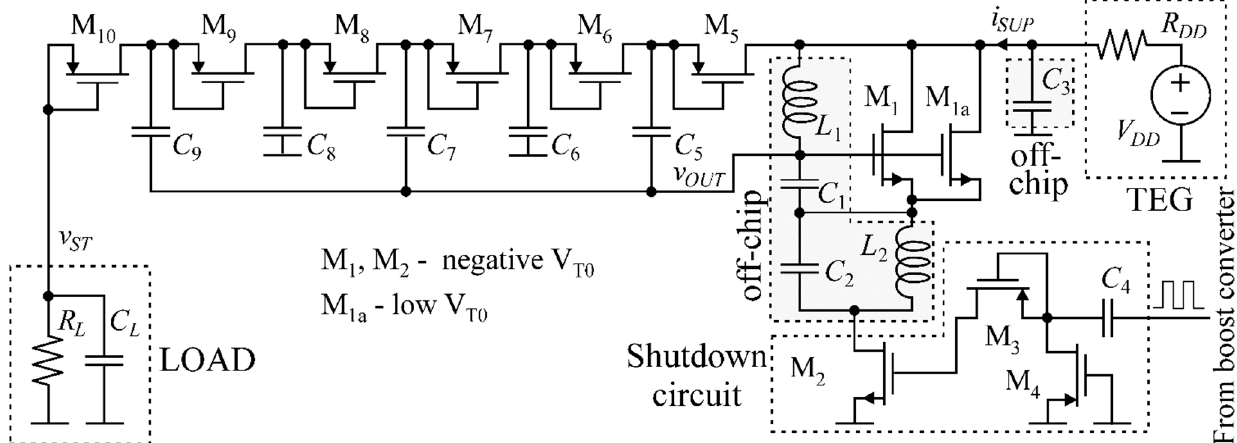
Figure 8. Starter based on the improved HSCO.